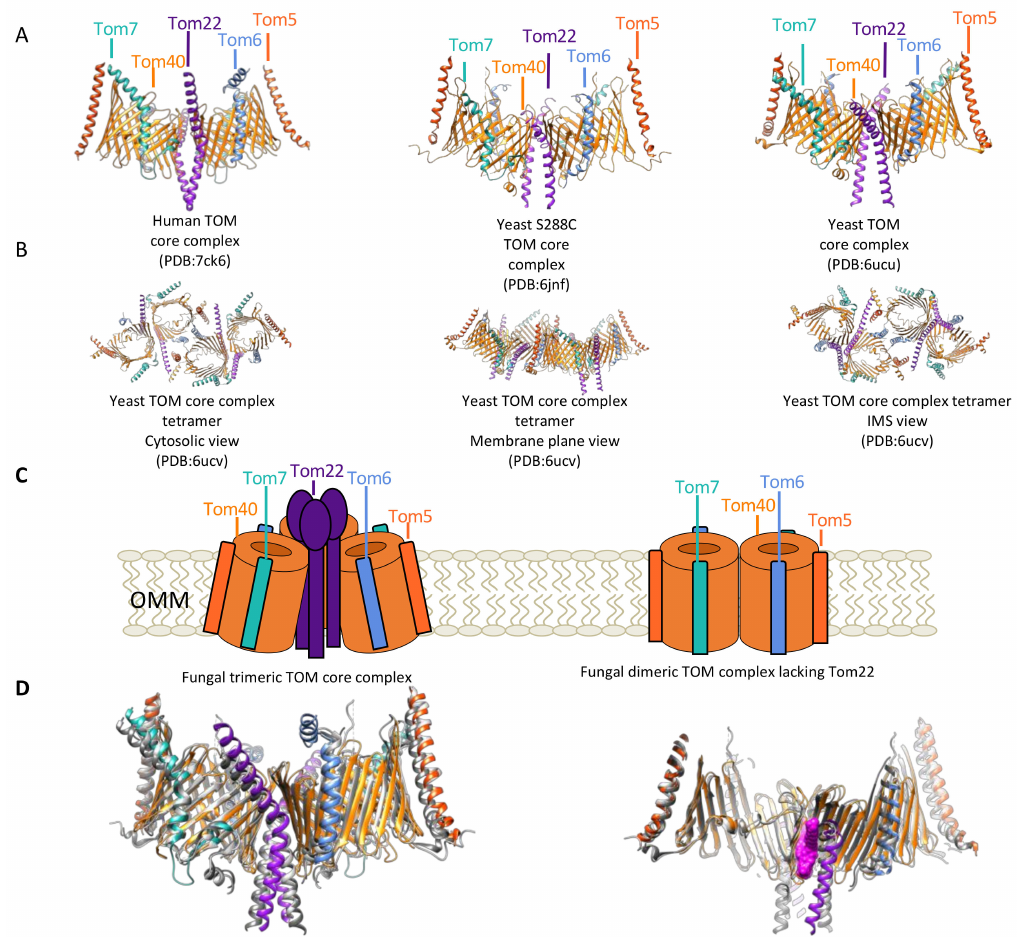
Figure 3. Arrangements of the TOM complex. ( A ) Structures of the human TOM core complex ( left , PDB:7ck6) illustrating high degrees of structural homology with some variations within the subunits and the dimeric form of two separately reported S. cerevisiae TOM core complex structures ( middle , PDB:6jnf; right , PDB:6ucu). All three structures show two Tom40 β -barrels (orange), with two Tom22 (purple) helices between the β -barrel, opposite the Tom22 dimers on both β -barrels is a curved Tom5 (vermillion), and on opposite sides of the β -barrel between Tom5 and Tom22 are Tom6 (light blue) and Tom7 (seafoam green). ( B ) Structures of tetrameric yeast TOM core complex. ( left ) Cytosolic view of yeast TOM core complex tetramer, illustrating Tom6 role in mediating the formation of the tetramer in yeast. ( middle ) Membrane plane view of yeast TOM core complex illustrating the tilt of the Tom40 β -barrels and how this results in the curvature of the tetrameric TOM complex. ( right ) IMS view of yeast TOM core complex showing proximity of IMS domains of β -barrel associated subunits to Tom40 domains that extend into the IMS. Notably, the N-terminal region of Tom40 and Tom5, and the C-terminal region of Tom40 and Tom7 are all in close proximity. ( C ) ( left ) Cartoon representation of fungal TOM core complex trimer, ( right ) fungal Tom40 complex dimer lacking Tom22 based on crosslinking and biochemical data. ( D ) ( left ) Superimposition of fungal TOM complexes (gray) and human TOM complex (colored), ( right ) Superimposition of fungal TOM complexes (gray) and human TOM complex with lipids/detergent in magenta (space-filling model). Superimposition highlights closeness of IMS region of hTom22, extended helical region of hTom6 that runs parallel to the OMM near the cytosol, and extended loop of Tom7 near the